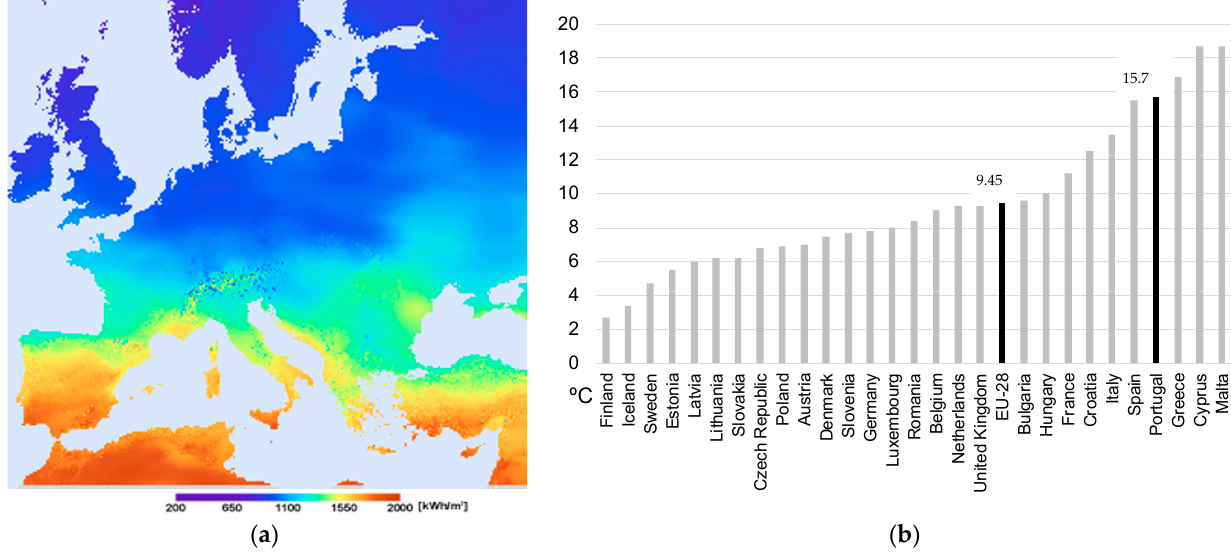
Figure 3. ( a ) Global horizontal solar radiation annual sum (adapted from [55]), ( b ) average temperature across Europe (data source [56]).